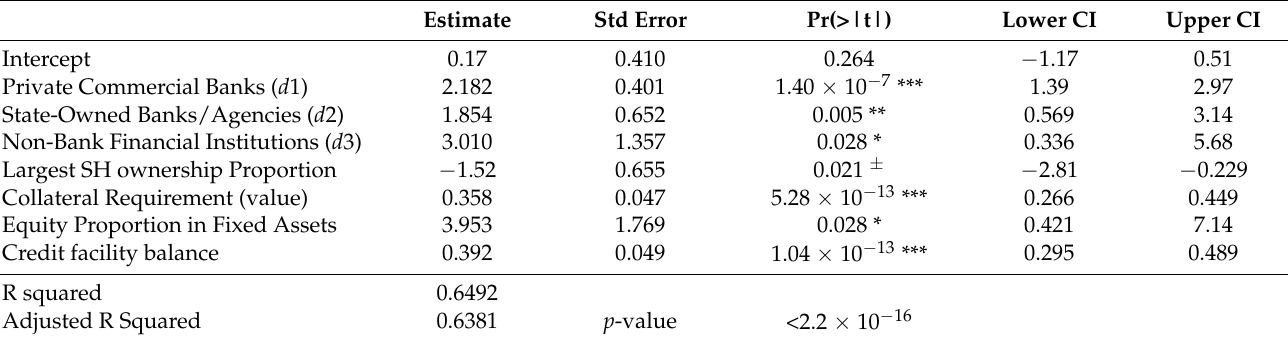
Table 2. Ordinary Least Square Regression Estimates and associated Confidence